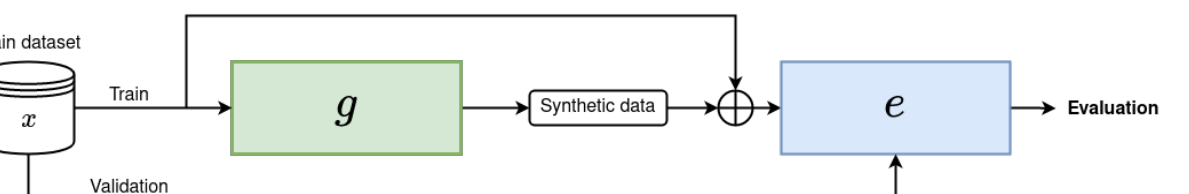
Figure 5. Illustration of the augmentation pipeline for a generative-model-based data augmentation. The input data, x , are fed into the generative model, g , which synthesizes additional data samples to augment the training set. The downstream architecture, e , which may take the form of a convolutional neural network or U-Net, is then trained on a combination of the synthesized data and real data from the training set. The training set is split into training and validation sets, where the validation set contains only real data for evaluation purposes. After training, the model can be evaluated using various test